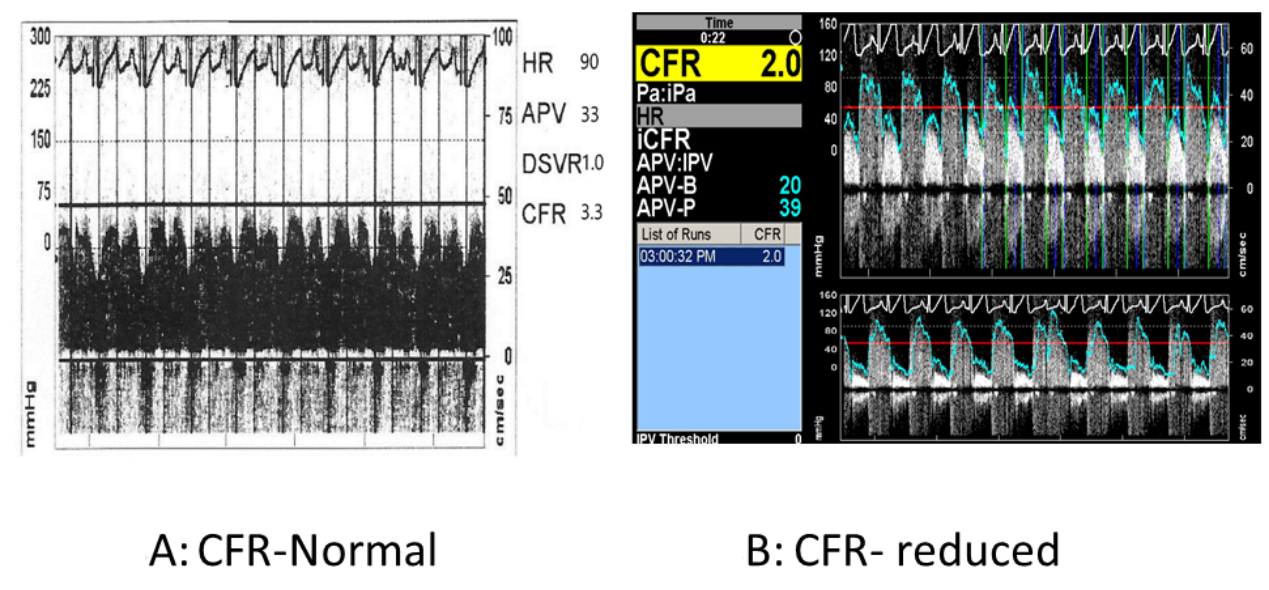
Figure 8. ( A , B ). Serial CFR at the time of cardiac catheterization and angiography in a pediatric HT recipient.